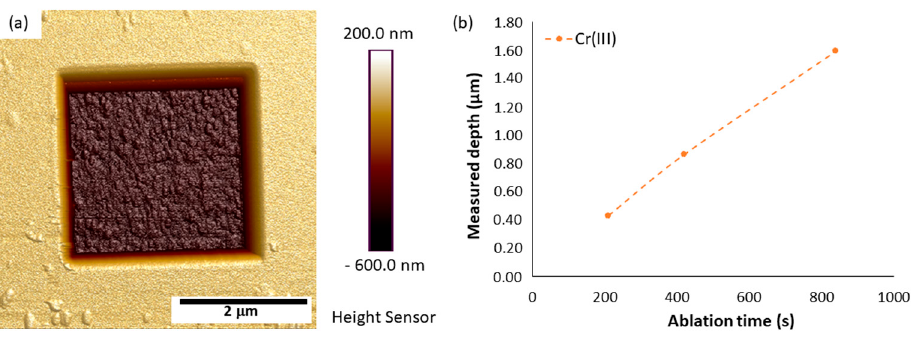
Figure 3. ( a ) Determination of the depth of FIB-machined pockets by atomic force microscopy and ( b ) a calibration curve of machining depth versus ablation time for trivalent chromium on 3 × 3 µm 2 square pockets milling.